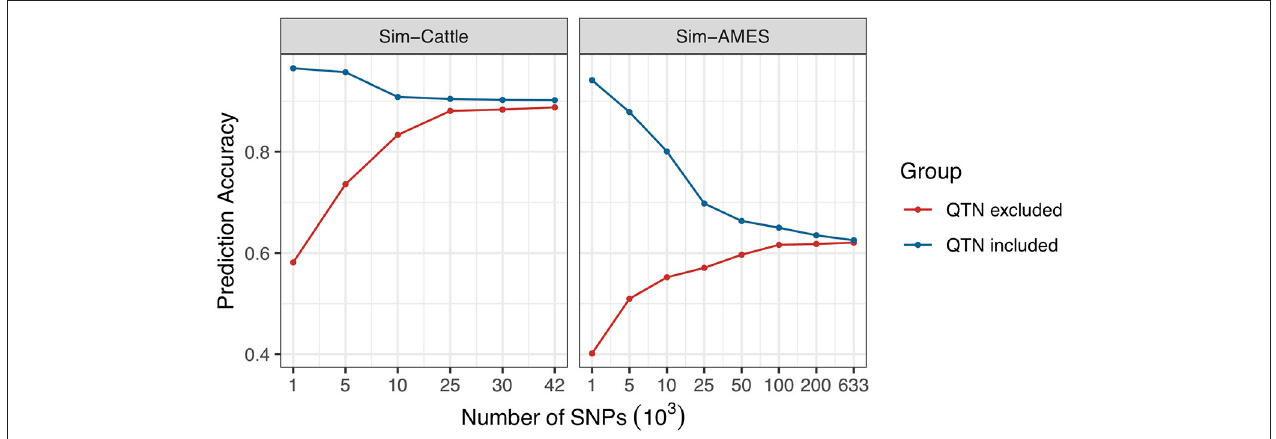
FIGURE 2 | Effect of marker density on the prediction accuracies of traits with simple genetic